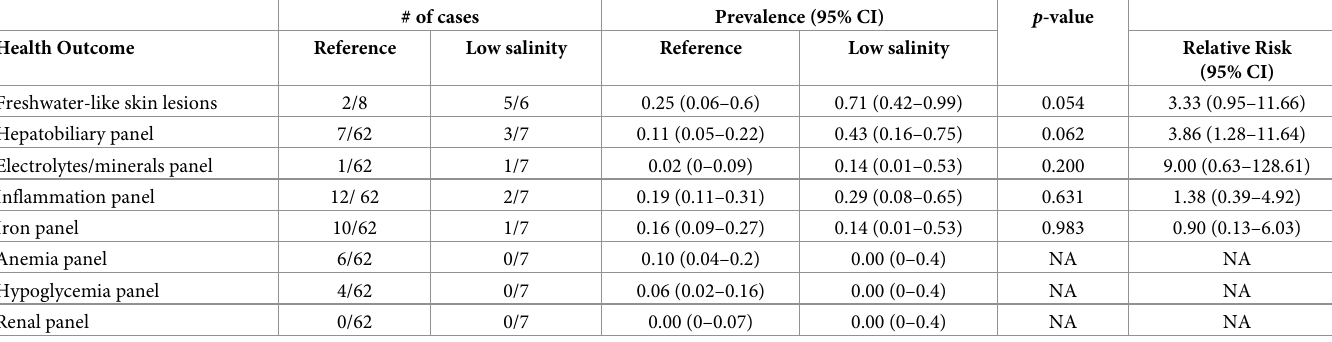
Table 3. The number of cases and prevalences of adverse health indicators in reference vs low salinity exposure